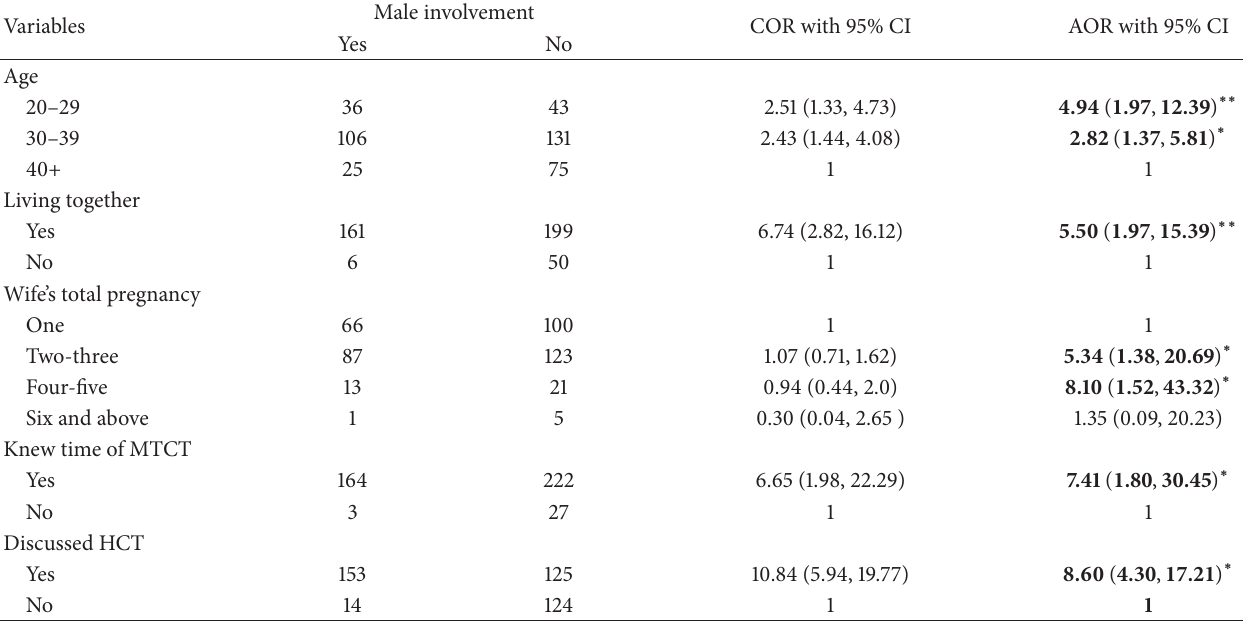
Table 4: Factors associated with male involvement in HCT in Gondar town, Northwest Ethiopia,